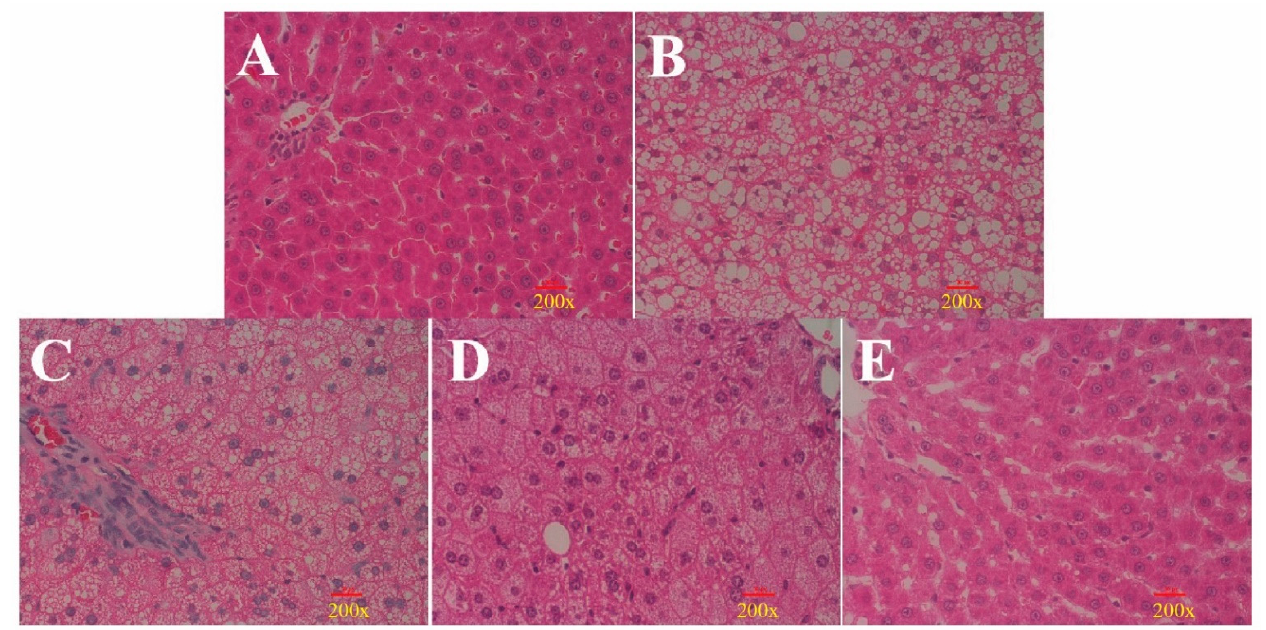
Figure 5. Effects of ORPS-1 (ORPS, Oudemansiella raphanipies polysaccharide) treatment on liver tissues observed via morphological analysis (hematoxylin and eosin staining, magnification 200×, microstructure). ( A ) normal control group; ( B ) nonalcoholic fatty liver disease model group; ( C ) LOPRS-1, 50 mg/kg ORPS-1 + HFD; ( D ) MOPRS-1, 100 mg/kg ORPS-1 + HFD; ( E ) HOPRS-1, 200 mg/kg ORPS-1 + HFD. ORPS, Oudemansiella raphanipies polysaccharide; HFD, high-fat diet.